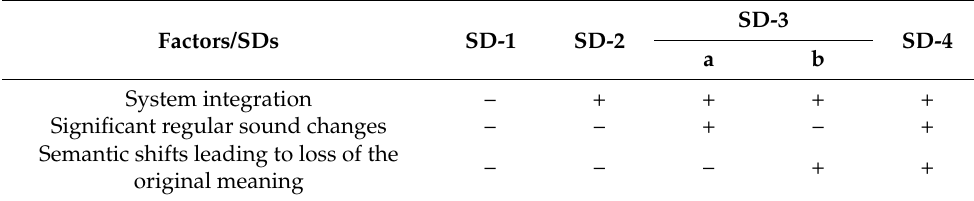
Table 1. Criteria for the classification of imitative words according to de-iconization stages (from Flaksman, 2015). Factors/SDs SD-1 SD-2